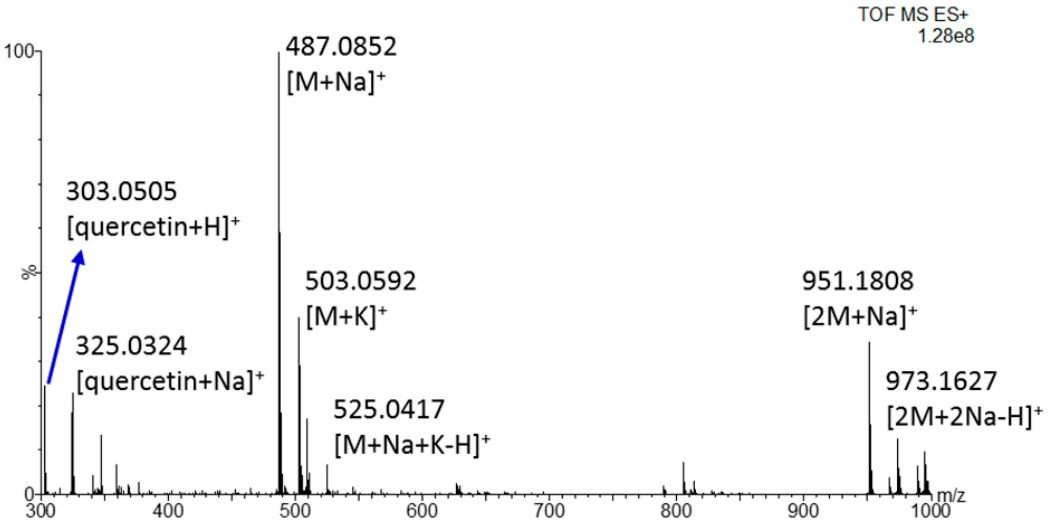
Figure 3. REIMS (+) spectrum, obtained by the direct infusion by the syringe pump (flow rate 50 Figure 3. REIMS ( + ) spectrum, obtained by the direct infusion by the syringe pump (flow rate 50 µ L / min) μ L/min) of isoquercetrin (1 ppm in methanol) over the mass range 300–100 m/z . of isoquercetrin (1 ppm in methanol) over the mass range 300–100 m / z . Similarly, the MS / MS spectrum of the ion at m / z 523.15, detected in negative mode and Similarly, the MS/MS spectrum of the ion at m/z 523.15, detected in negative mode and tentatively identified as deprotonated verminoside, that is a caffeic acid derivative, produced the fragments at m/z 179.02 and 161.01 which could be the deprotonated and the dehydrated caffeic acid, respectively (Figure S9).